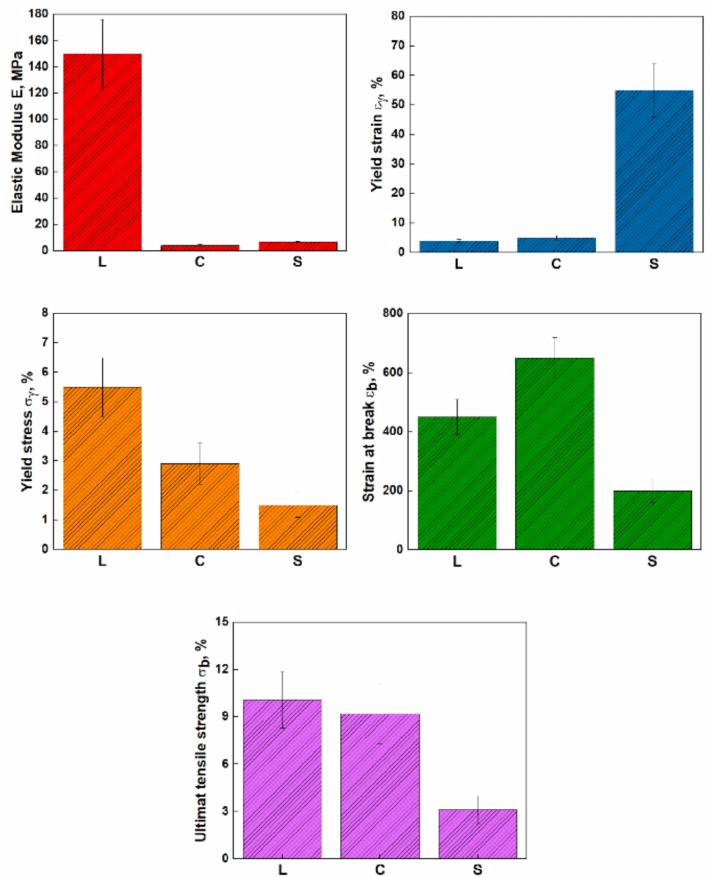
Figure 5. Mechanical properties of PLA-PI-PLA with different morphologies (L = lamellae; C = cylinders; S = spheres). Data from